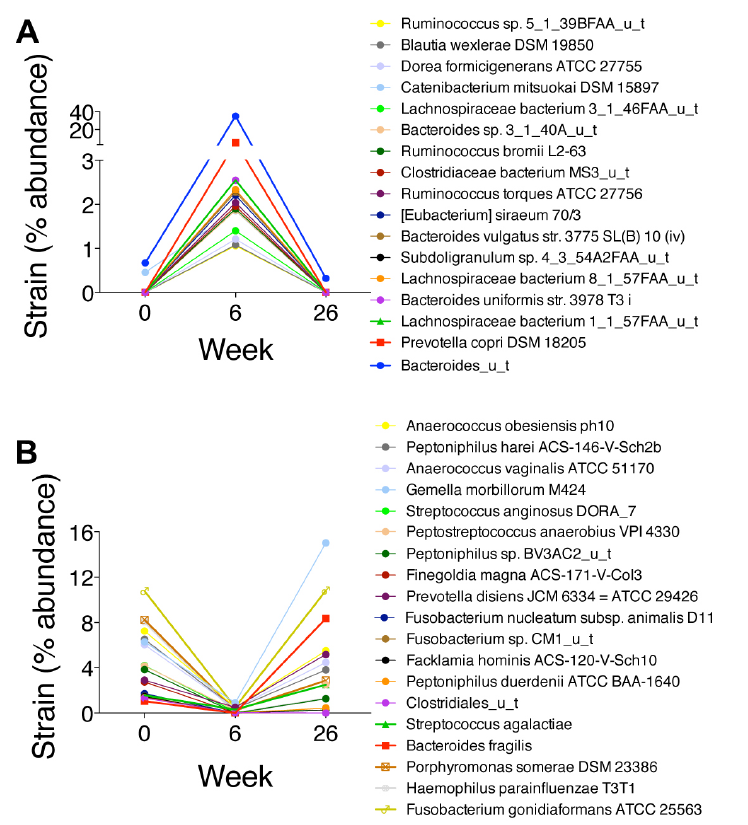
Figure 4. Changes in the microbiota at the strain level in PID3, the participant who had the highest zonulin, intestinal fatty acid binding protein (I-FABP), soluble TNF receptors I and II, soluble TNF receptor superfamily 8 (sCD30), and osteopontin levels and had a dramatic shift in distribution. A) Increases in strain abundance by at least 1%. B) Decreases in strain abundance by at least